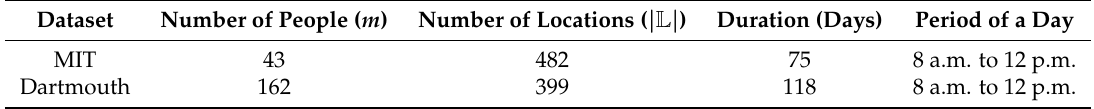
Table 1. Summary of two datasets after locations and users